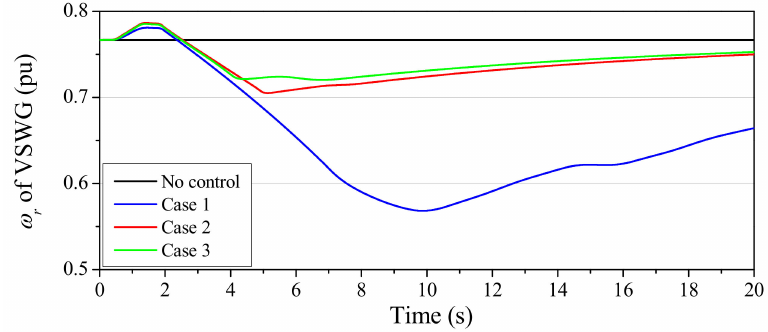
Figure 23. Rotor speed of the VSWG (with PV system installed).